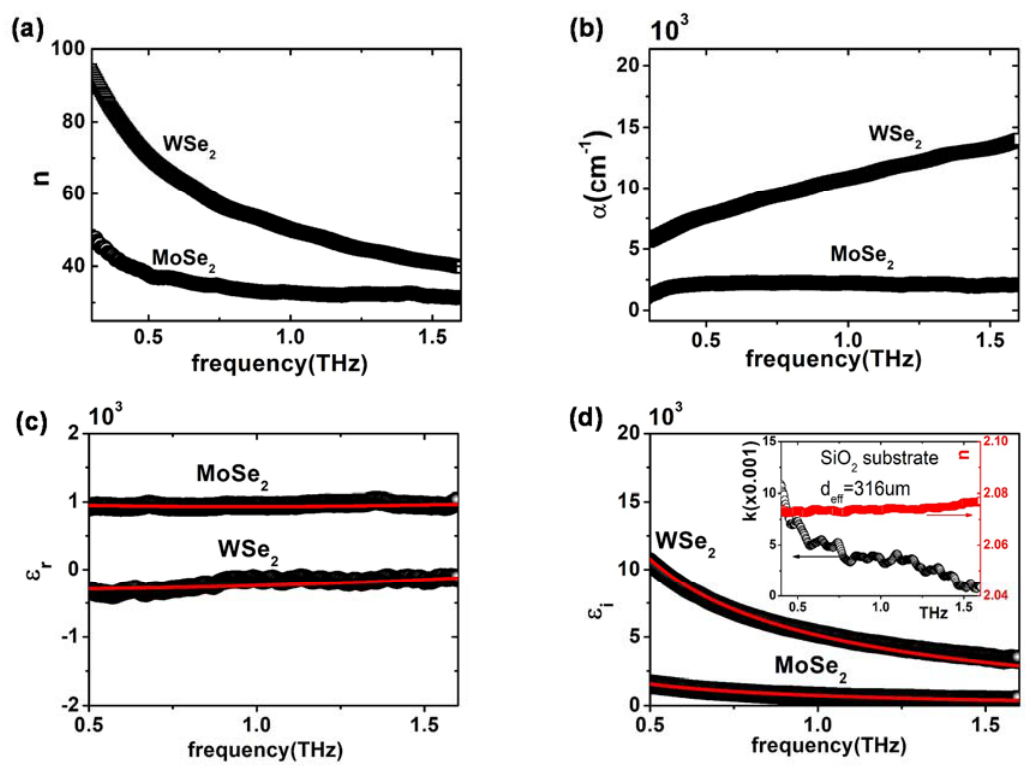
Figure 4. ( a , b ) show the refractive index n and the absorption coefficient respectively of the two samples. ( c , d ) report the real ( ε r ) and imaginary ( ε i ) parts of dielectric function of TMD’s films as extracted by using the TF model. The red line corresponds to the Drude–Smith model fit whose parameters are reported in Table 1. Inset: refractive index and extinction coefficient versus frequency of the SiO 2 substrate.